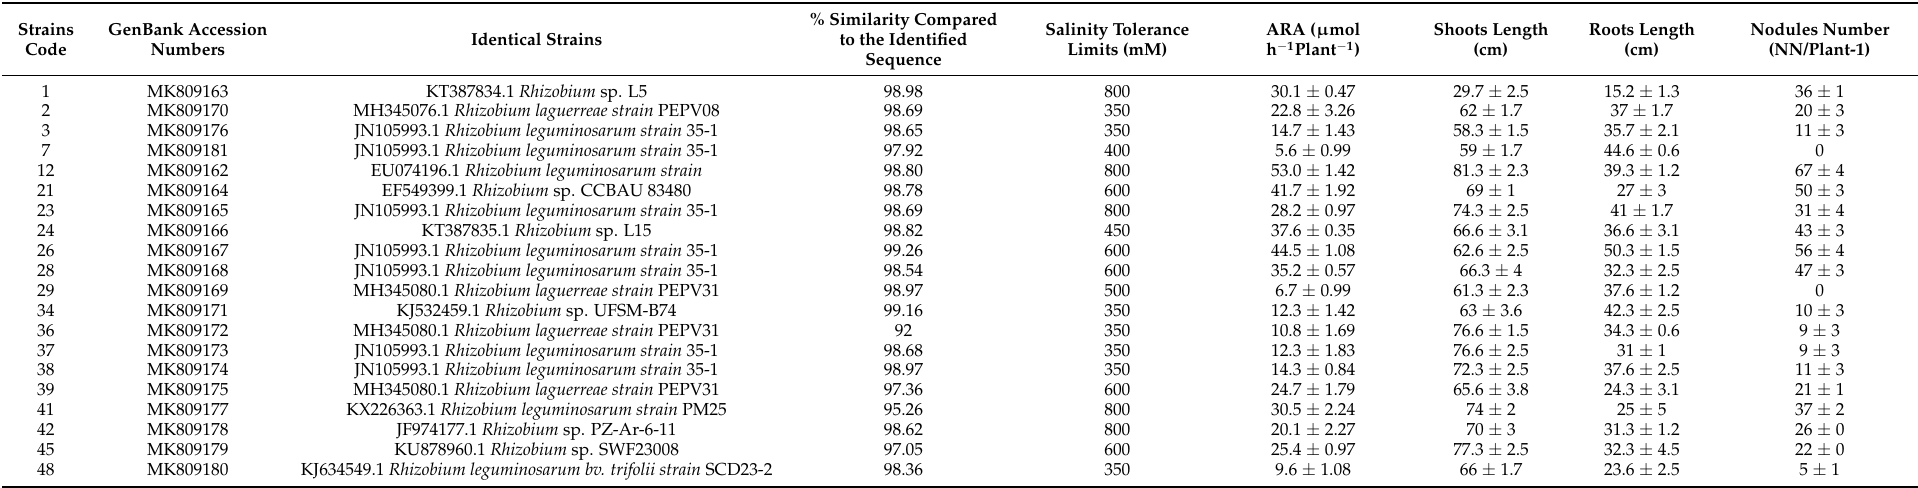
Table 5. Identification, percentage of similarity of strains, growth and nodulation test of Vicia faba inoculated with different bacterial strains (Salinity tolerance limits, ARA, shoots length, roots length and Nodules number). The values are the average of three repetitions in three independent pots and the molecular characterization of 20 isolates by PCR/sequencing of the 16rDNA